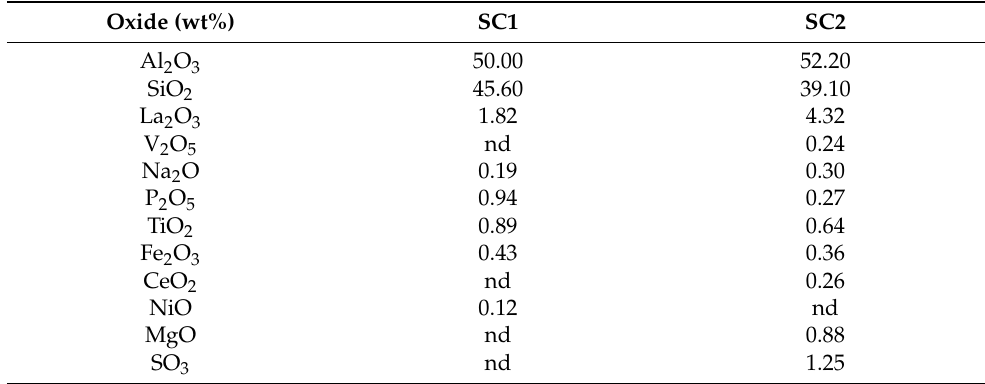
Figure 2. X-ray diffraction patterns of the ( a ) SC1 and ( b ) SC2 samples. The chemical compositions of the two starting spent FCC powders are shown in Table 1. According to the authors of [7], both powders are mainly composed of alumina and silica. The nature and amounts of the minor impurities are similar, while the lanthanum contents are significantly different. Table 1. Chemical composition (wt%) for both spent FCC powders.